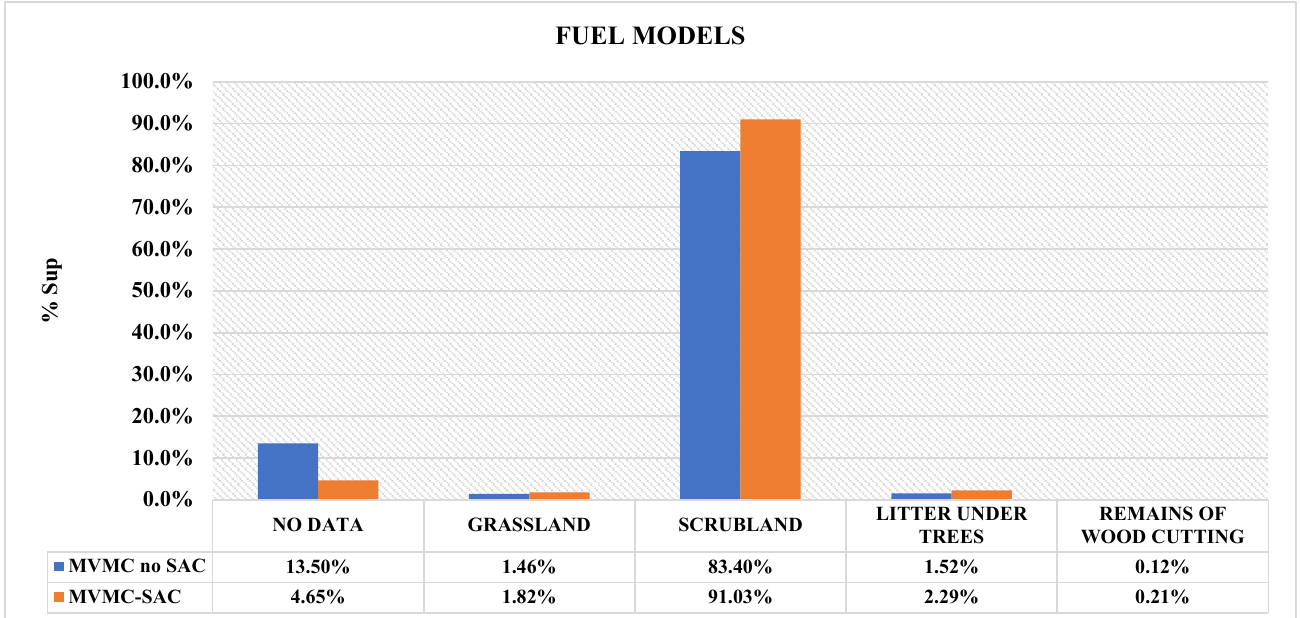
Figure 8. Fuel models in MVMC no SAC and in MVMC-SAC. The most frequent fuel model in both territorial units was scrubland, with very similar percentages in both cases. The remaining fuel models were very poorly represented in MVMC-SAC and MVMC no SAC.